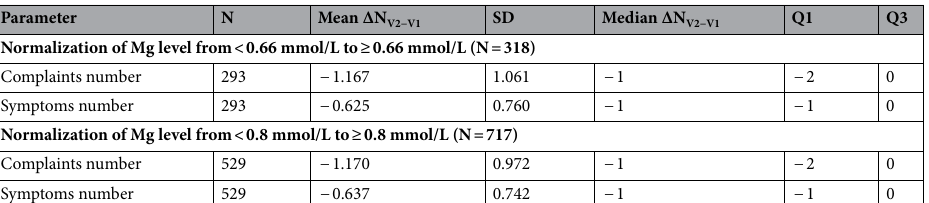
Parameter N Mean ΔN V2−V1 SD Median ΔN V2−V1 Q1 Q3